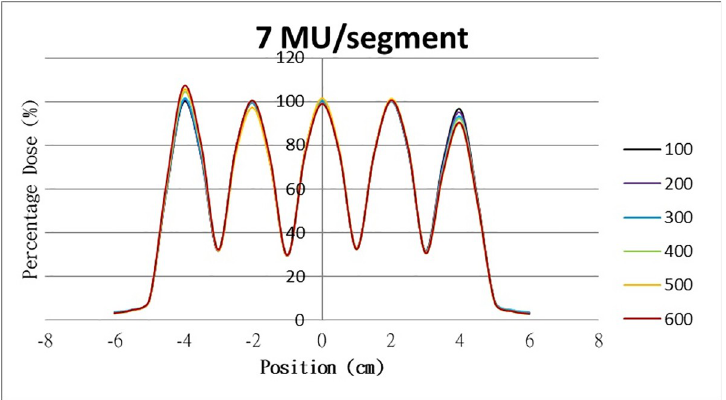
Fig 12. Overshoot effect measured at various MU values and dose rates. Overshoot effect, at various dose rates, for (6) 1 MU, (7) 2 MU, (8) 3 MU, (9) 4 MU, (10) 5 MU, (11) 6 MU, (12) 7 MU, (13) 8 MU, (14) 9 MU, (15) and 10 MU.